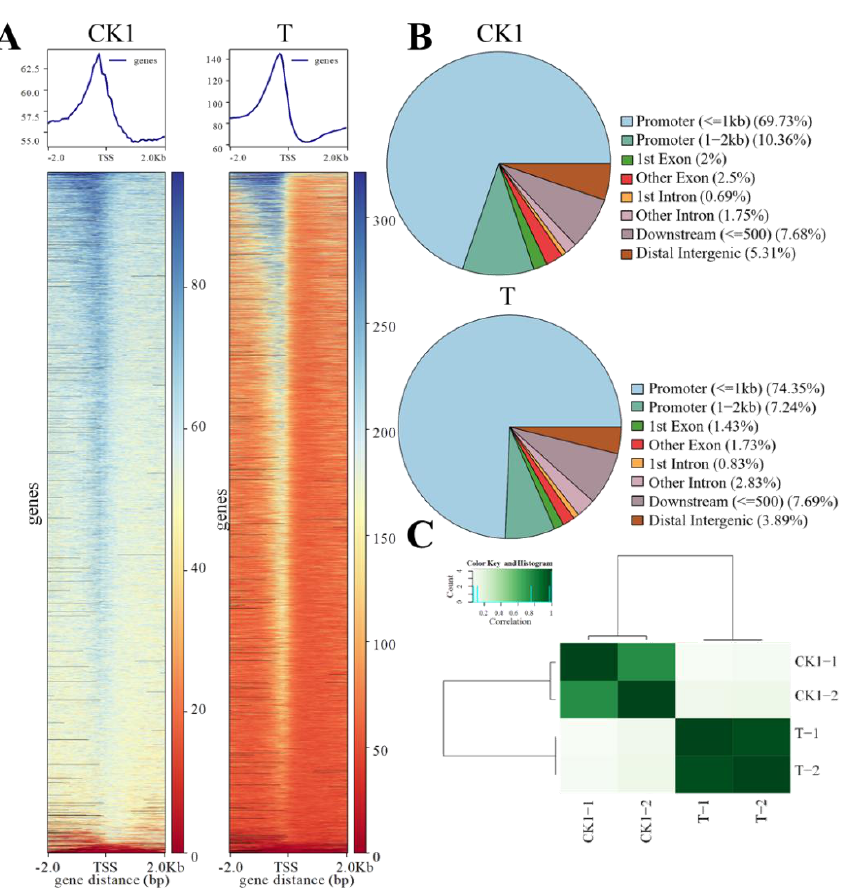
Figure 1. Chromatin accessibility landscape of CK1 and T samples. ( A ) Average plots and heat maps showing the signals at the TSS in the ATAC-seq data sets. ( B ) Distribution of peak in each functional region of the gene in CK1 and T samples. ( C ) Heatmap showing the Pearson correlation coefficient of two ATAC-seq replicates of two group samples.